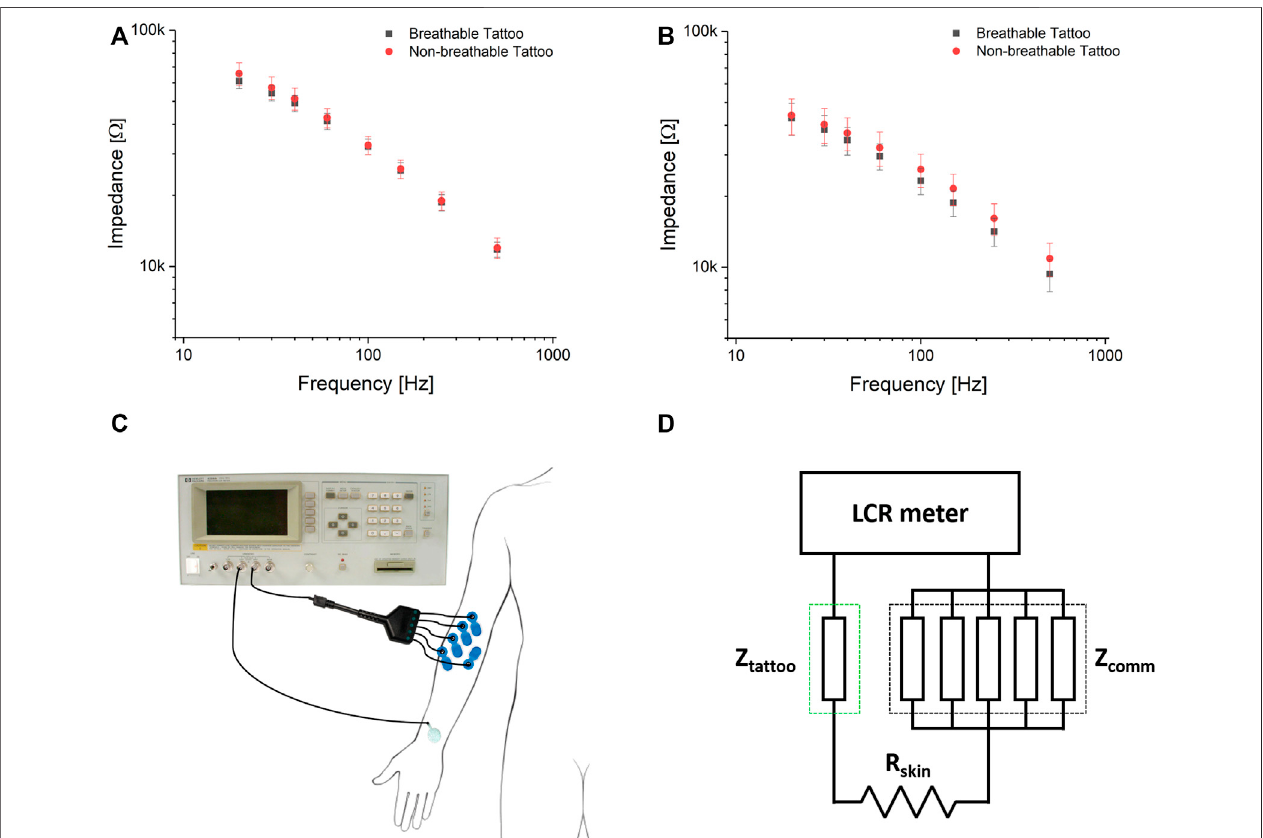
Frontiers in Bioengineering and Biotechnology |